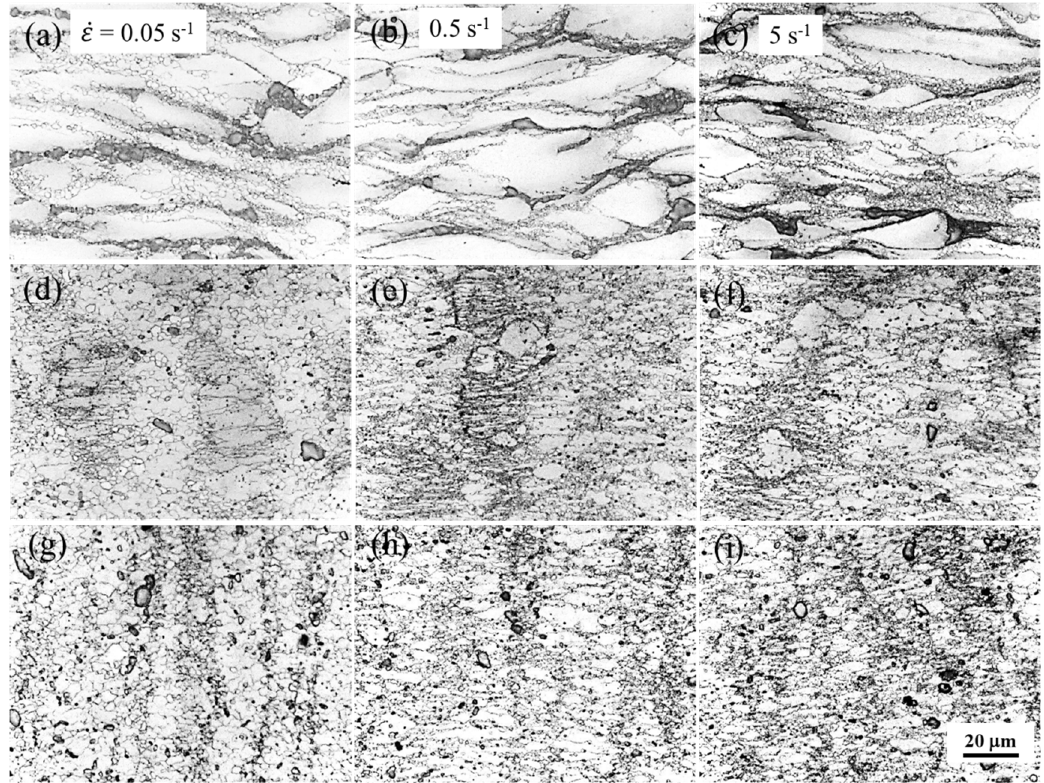
Figure 8. Typical microstructures after being compressed up to a true strain of 1.0 at various strain rates of 0.05, 0.5, and 5 s − 1 for (a-c) AC, (d-f) Ex-1, and (g-i) Ex-2 WE43 alloy, respectively.